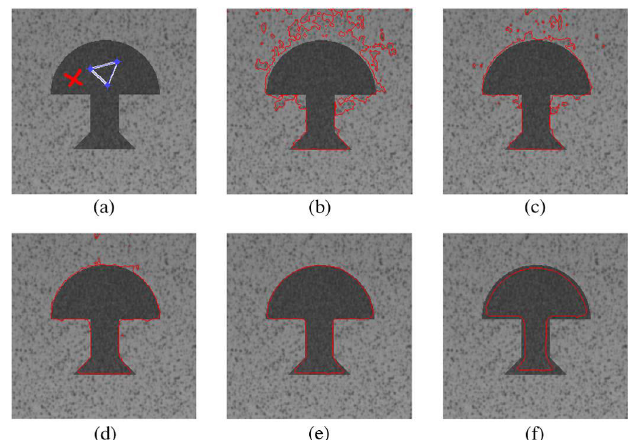
Figure 6. Impact of the parameter α on the accuracy of the segmentation result ( cf . [14]): ( a ) initial contour; ( b ) α = 0.5 and β = 3.5; ( c ) α = 0.75 and β = 3.5; ( d ) α = 1 and β = 3.5; ( e ) α = 2 and β = 3.5; ( f ) α = 10 and β = 3.5.